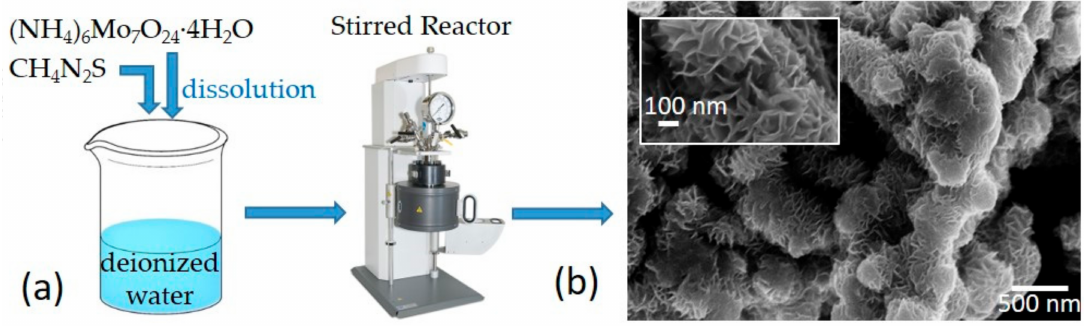
Figure 1. ( a ) Schematic of the MoS 2 synthesis by the hydrothermal method; ( b ) Scanning electron microscope image of a MoS 2